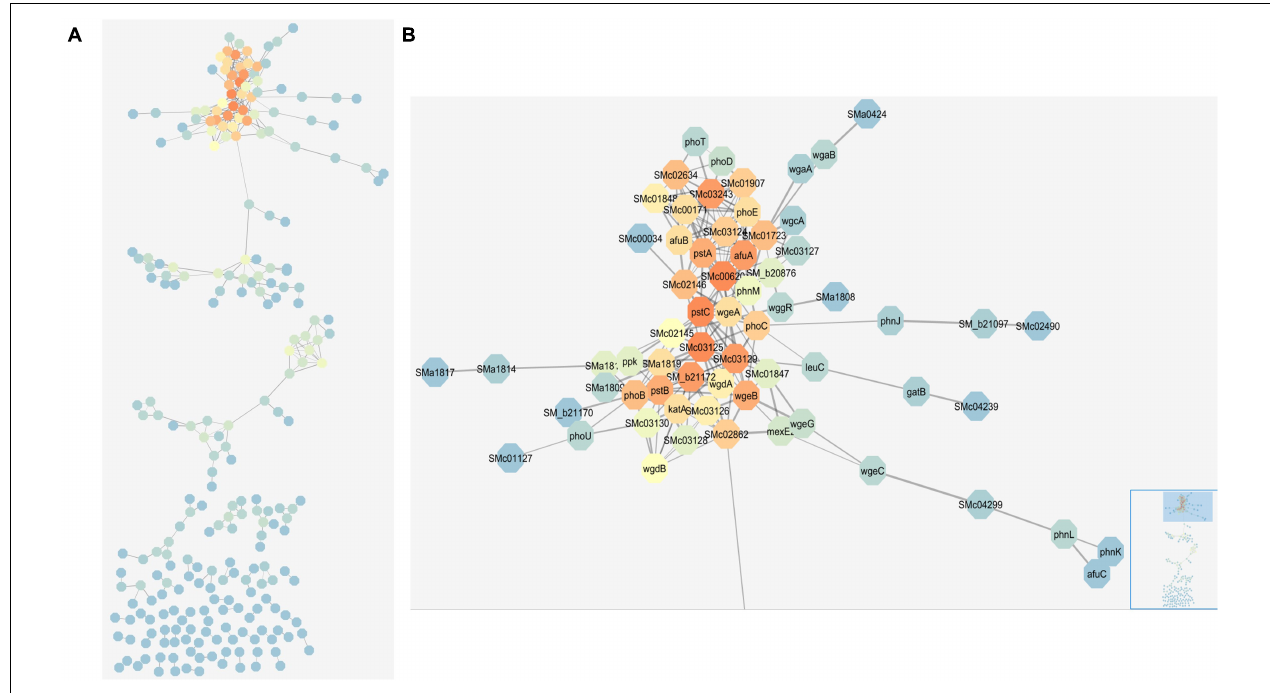
FIGURE 4 | Network map of connected genes based on weighted co-expression analysis. Network map created in Cytoscape depicting genes that are linked based on their expression patterns and correlation with each other. (A) Shows the full network map. (B) Shows the large group at the top of the map including many core phosphate stress response genes. Colors represent degrees and depict how connected a gene is to other genes in the map. The color scheme starts with blue as the least connected (fewest degrees) and flows through green to yellow to orange as the most connected (highest degrees). The bottom right inset in panel (B) highlights the area of the full network map that is